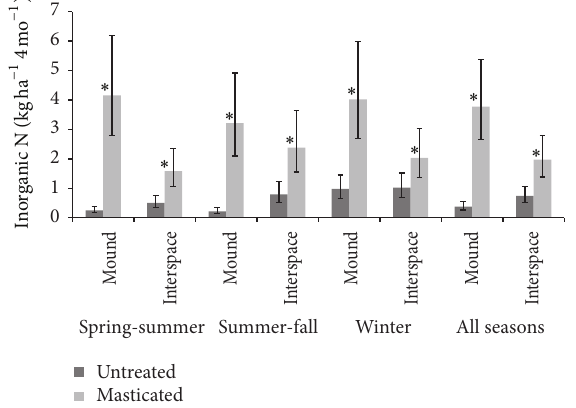
Figure 3: Juniper tree reduction with mechanical mastication alters inorganic N (NO 3− + NH 4+ ) levels measured with ion exchange membranes in intact tree mounds and interspaces between trees. Asterisks indicate differences between column pairs ( 𝑃 < 0.01 ).